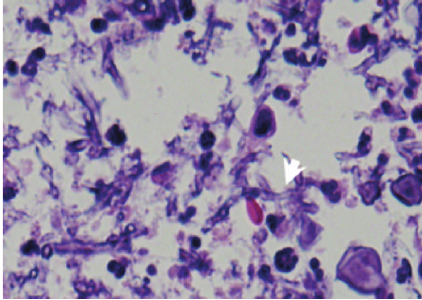
Figure 6: BAL cytology. H&E stain (high power, zoom) showing fungus hyphae which were hyaline and septated with 45-degree branching